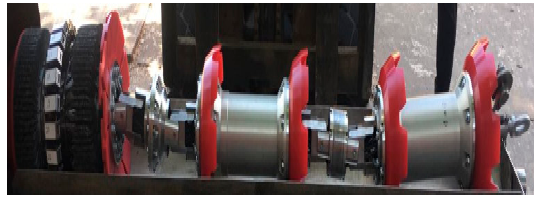
Figure 8. Centerline measurement system in field test.